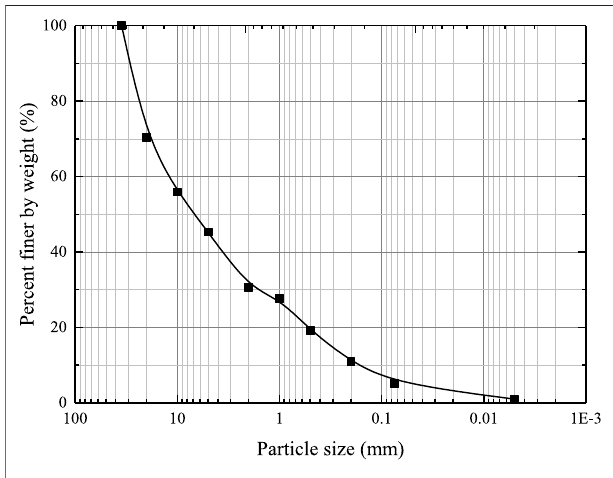
FIGURE 1 | Particle size distribution of SRM.